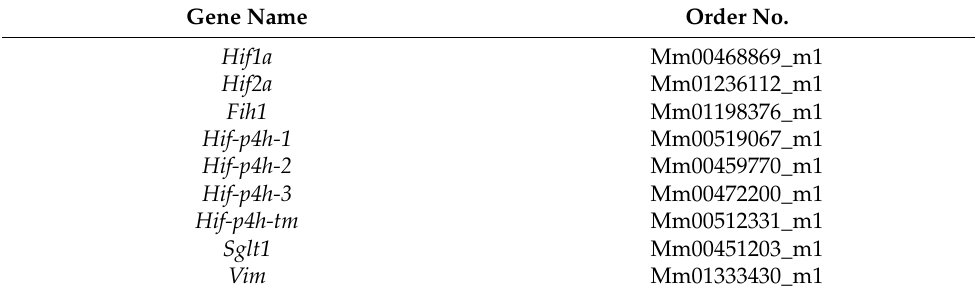
Table 2. Probes for